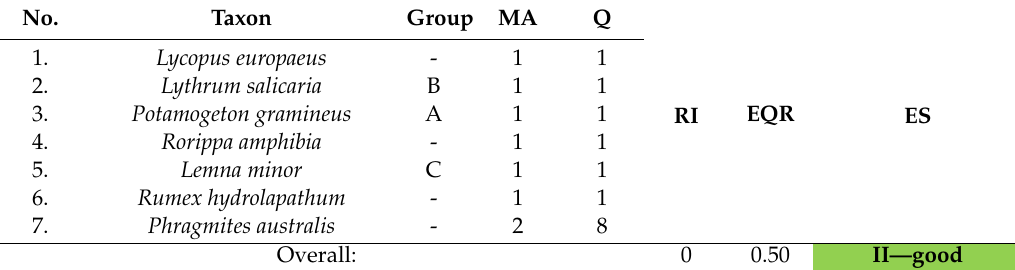
Table 18. Summary of RI-BG results, May 2017, section below the SHP on the